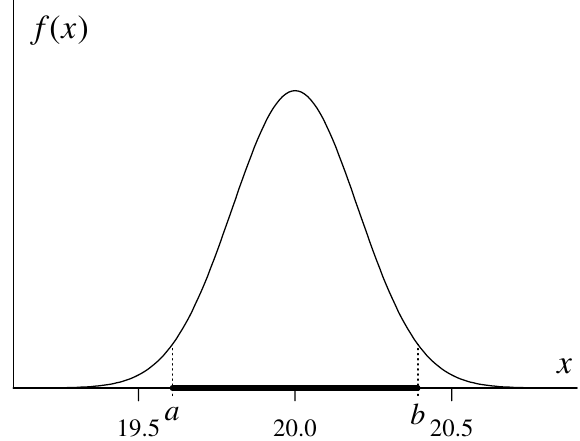
Fig. 1. A 95% probability interval [ a, b ] for the random vari- able X with the normal distribution with mean 20 and stan- dard deviation 0.2. a = 19 . 61 , b = 20 .